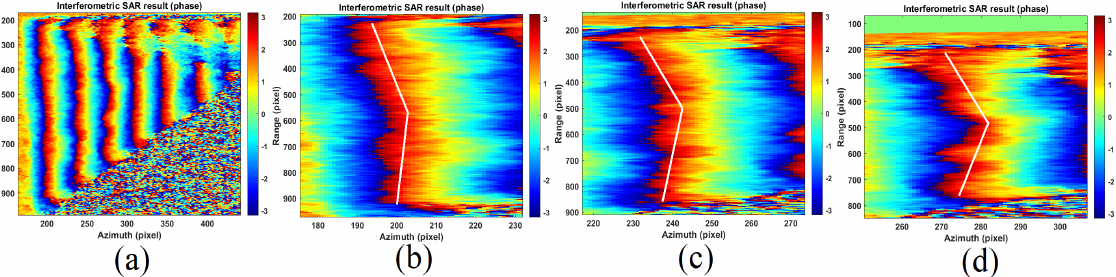
Figure 17. Representation in particular of the pyramid of Kefren. Interferometric phases. ( a ): north side. ( b – d ): magnification of interferometric fringe 1, 2, and 3.